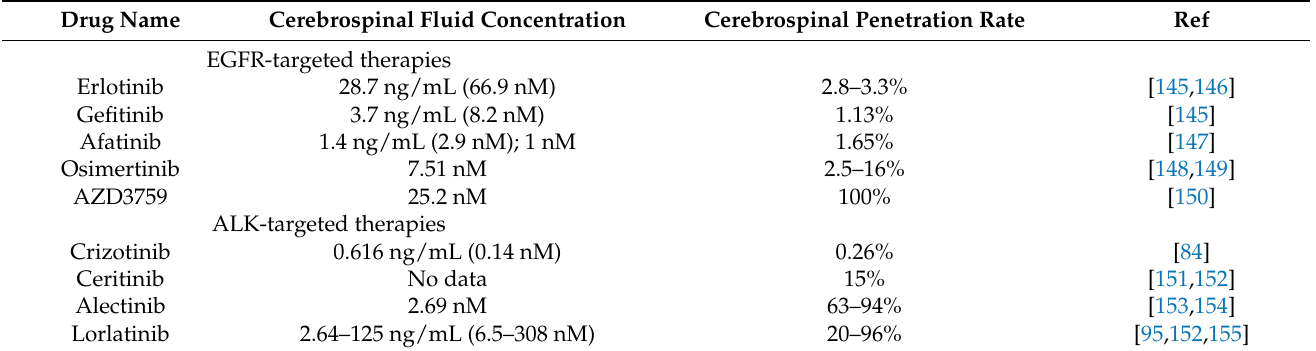
Table 2. Concentration of tyrosine kinase inhibitors in the cerebrospinal